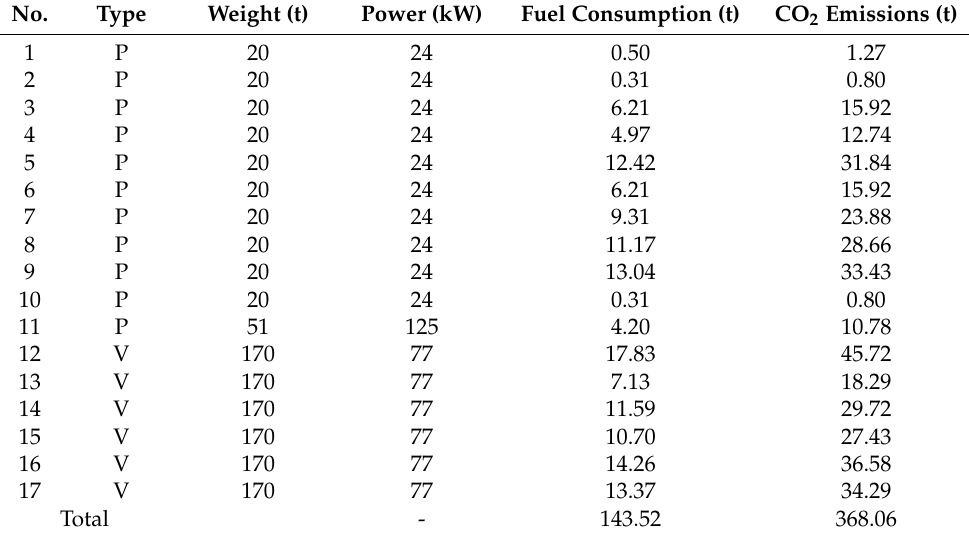
Table 2. The 2021 ferryboat carbon emissions statistics .